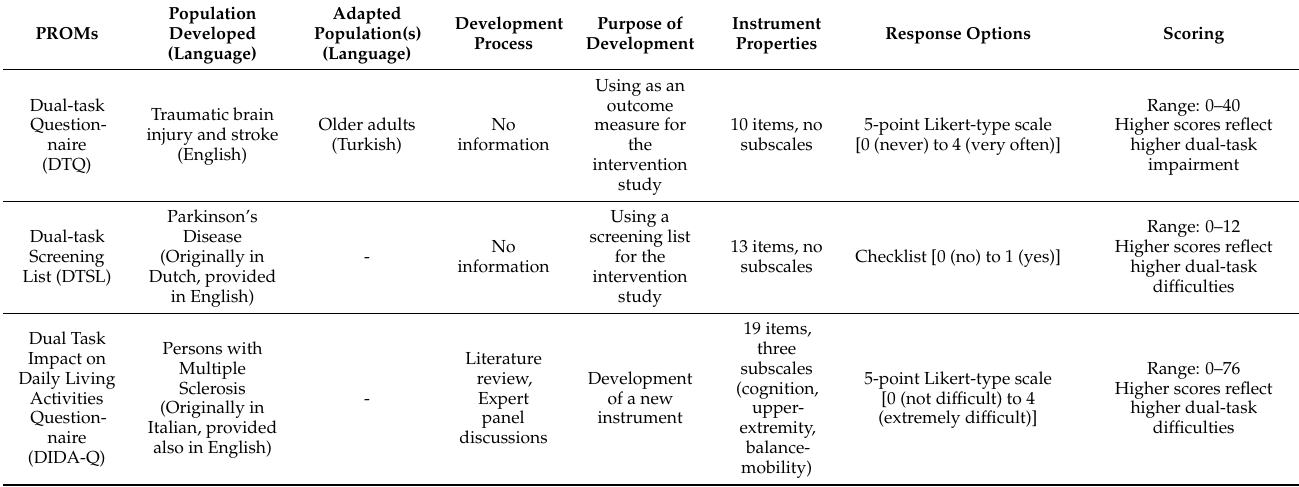
Table 1. Characteristics of PROMs assessing dual-task difficulties.